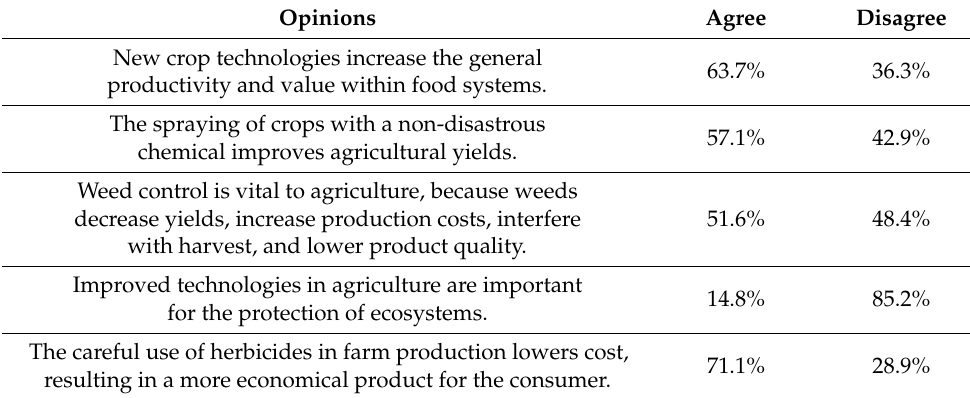
25.3% 74.7% 63.5% 36.5% 72.7% 27.3% 41.6% 58.4%